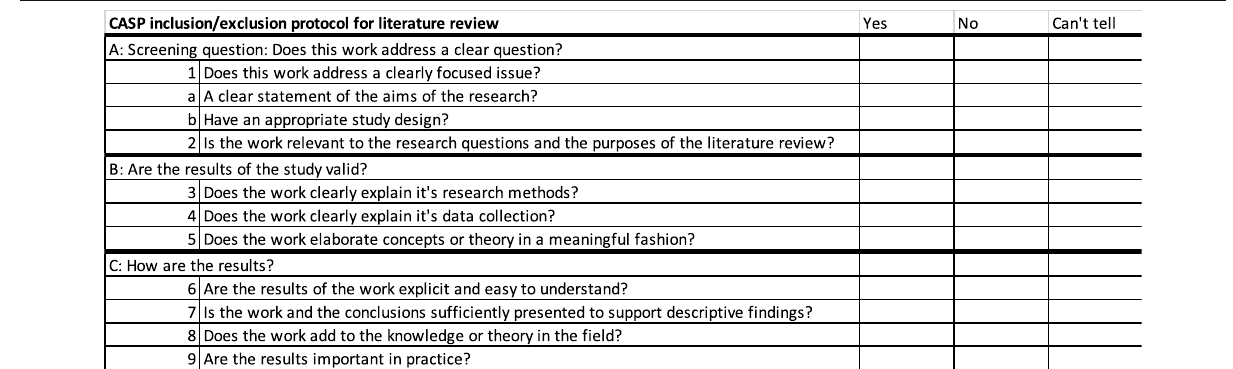
Table 3 CASP list for inclusion/exclusion adapted from [35]